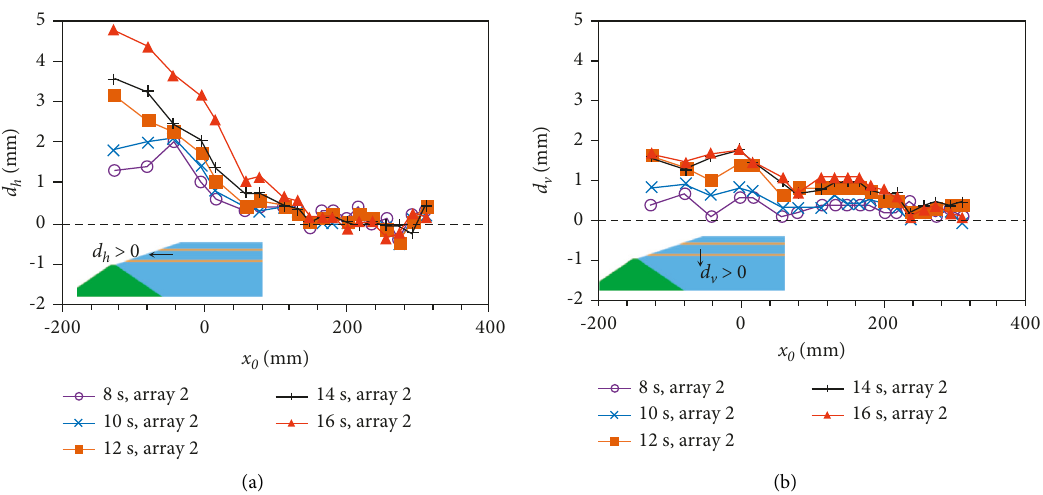
Figure 10: Horizontal distributions of (a) horizontal and (b) vertical displacements of the trace markers in array 2 below the relatively shallow silty layer in stage 2.